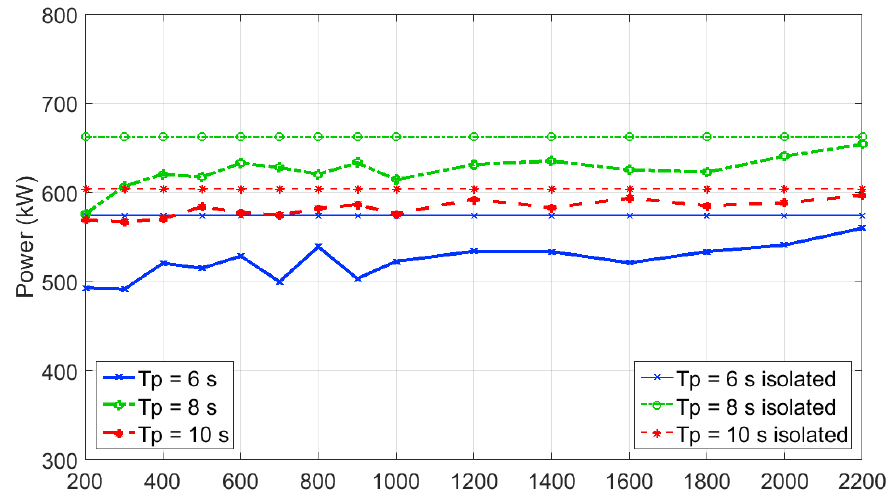
Figure 11. Power output of a WEC farm for various interarray separation distances D 1 for irregular waves of T p = 6 s ( a ), T p = 8 s ( b ), and T p = 10 s ( c ) for 0 ◦ (solid line), 22.5 ◦ (dash-dot line), and 45 ◦ (dashed line). Thin horizontal lines indicate 2 × P array . Thick lines indicate P farm .